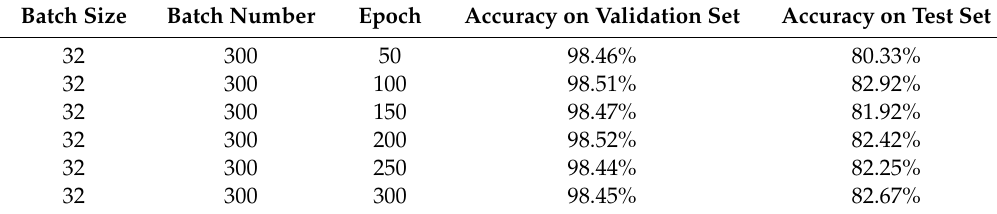
Table 3. Intrusion detection accuracy of di ff erent number of epochs.